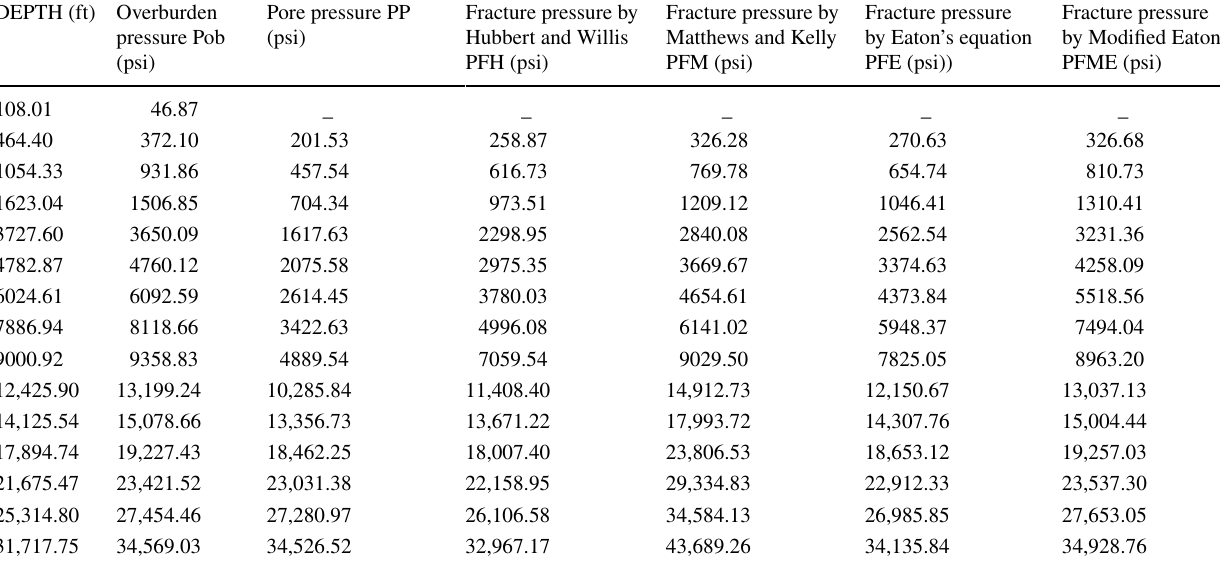
Table 3 Fracture pressure on the Tulamura anticline using pore pressure by the proposed new equation DEPTH (ft) Overburden pressure